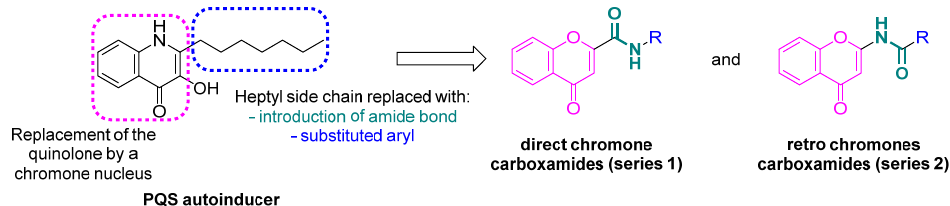
Figure 1. Rational design of chromone carboxamides as PQS analogs.